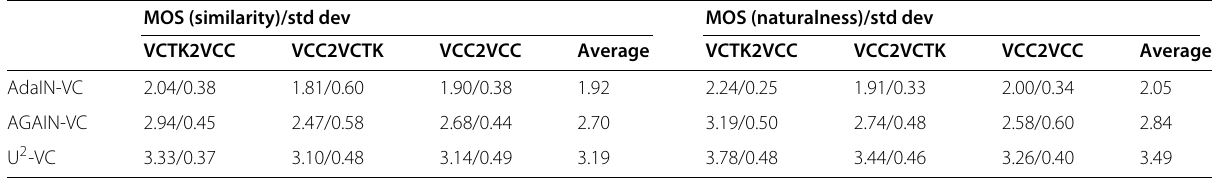
Table 13 Subjective evaluation results with standard deviation (std dev) of voice conversion in cross-lingual scenario. The results are listd as MOS/std